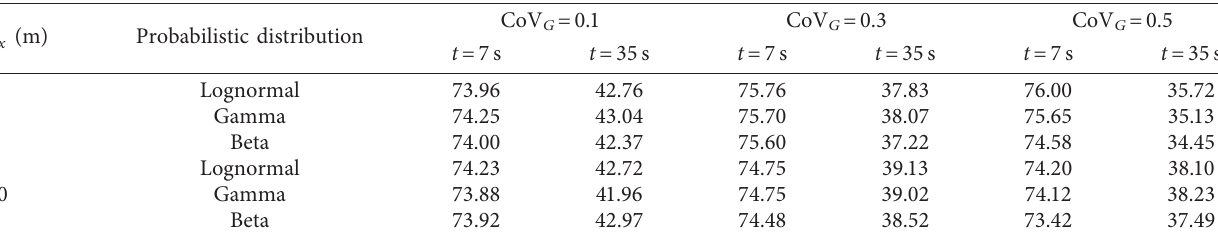
Table 2: Summary of μ � 7.25m and t � 7 and 35s (10 − 2 ). Q at z